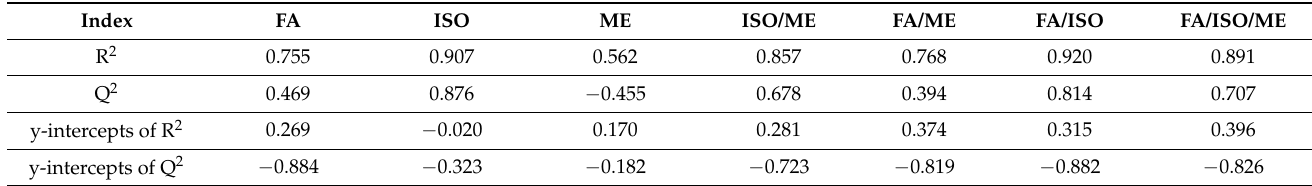
Figure 2. OPLS-DA score plots of Hebei samples obtained by the chemical analysis of: ( A ) Mineral elements; ( B ) Isotopes; ( C ) Fatty acids; ( D ) Fatty acids combined with isotopes. Table 3. Characteristics of OPLS-DA models of milk in Hebei